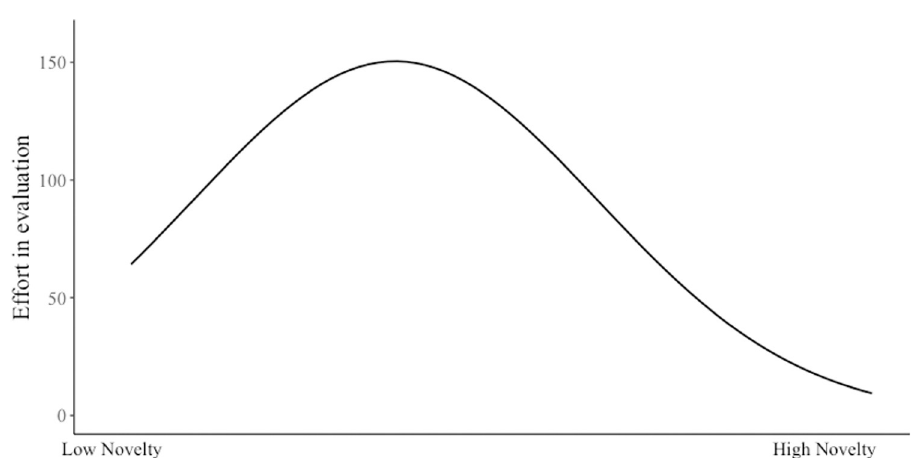
Fig 4. Curvilinear relationship between perceived novelty and efforts in